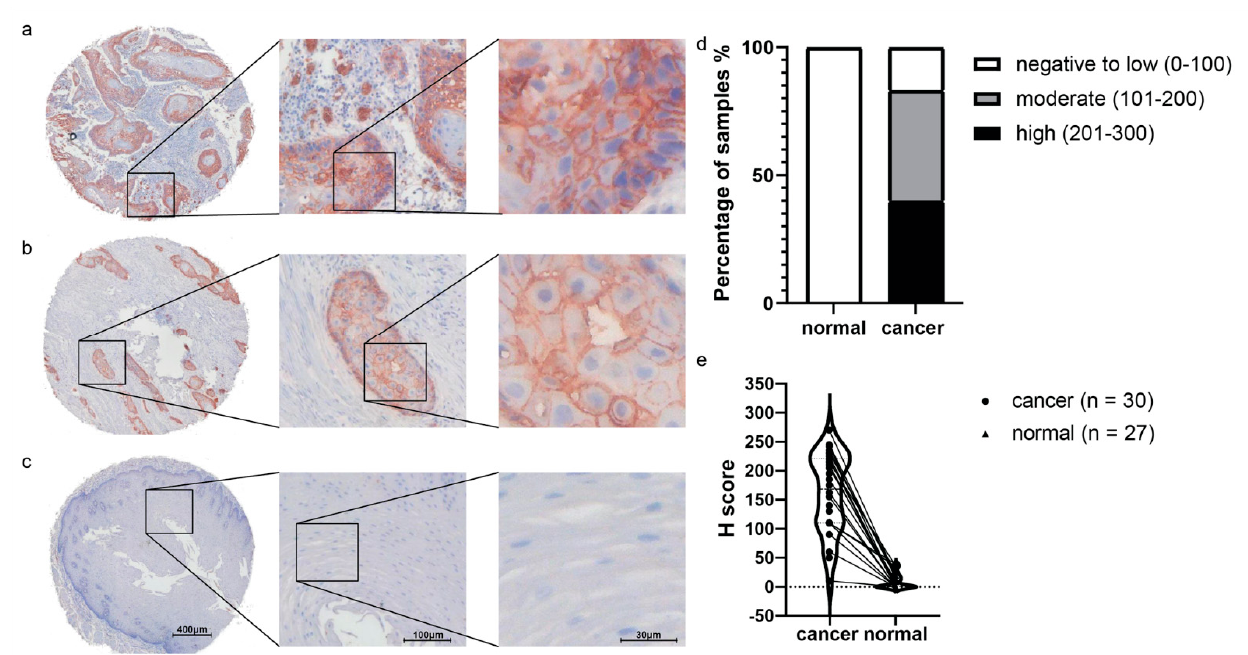
Figure 3. Anti-GLUT1 immunohistochemistry results in both ESCC and normal esophagus tissue. Representative images of anti-GLUT1 IHC staining results (red) in ESCC patient’s tissue (( a ) and ( b ), different patients for each TMA displayed), and normal esophagus tissue ( c ). The images of ( a – c ) are from the same TMA slice. ( d ) Bar graph comparison results of H-Score in ESCC tissues to normal esophagus tissues, illustrating a significant difference in staining intensity ( p value < 0.001). ( e ) Comparison of H-Score in ESCC tissues to normal esophagus tissues. Each line connects paired data from the same patient.